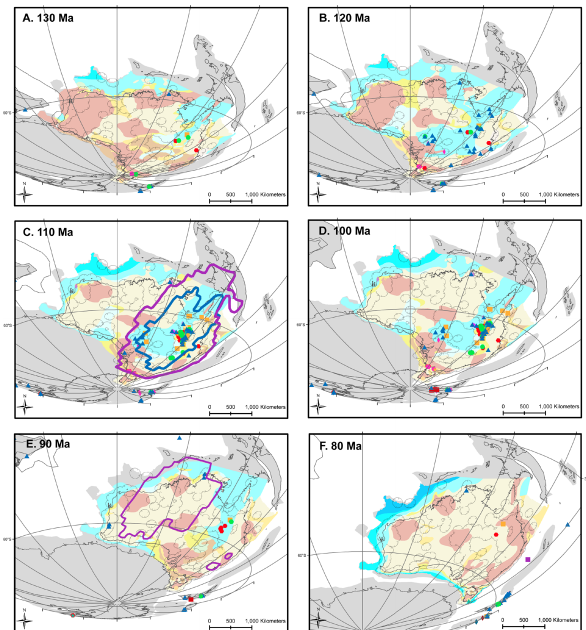
Fig. 9. Paleogeographic reconstructions suggest that Cretaceous in- undation of central eastern Australia peaked by ∼ 120Ma, and the fossil indicators hint at pockets of shallow marine environments per- sisting beyond 100Ma. The eastward sweeping negative dynamic topography system from a sinking Pacific-derived slab has been linked to the inundation pattern, better modelled by Model C (blue) than Model B (purple) in the geodynamic modelling results of Gur- nis et al. (1998), highlighting how paleogeography can be used to validate numerical model predictions of basin evolution.